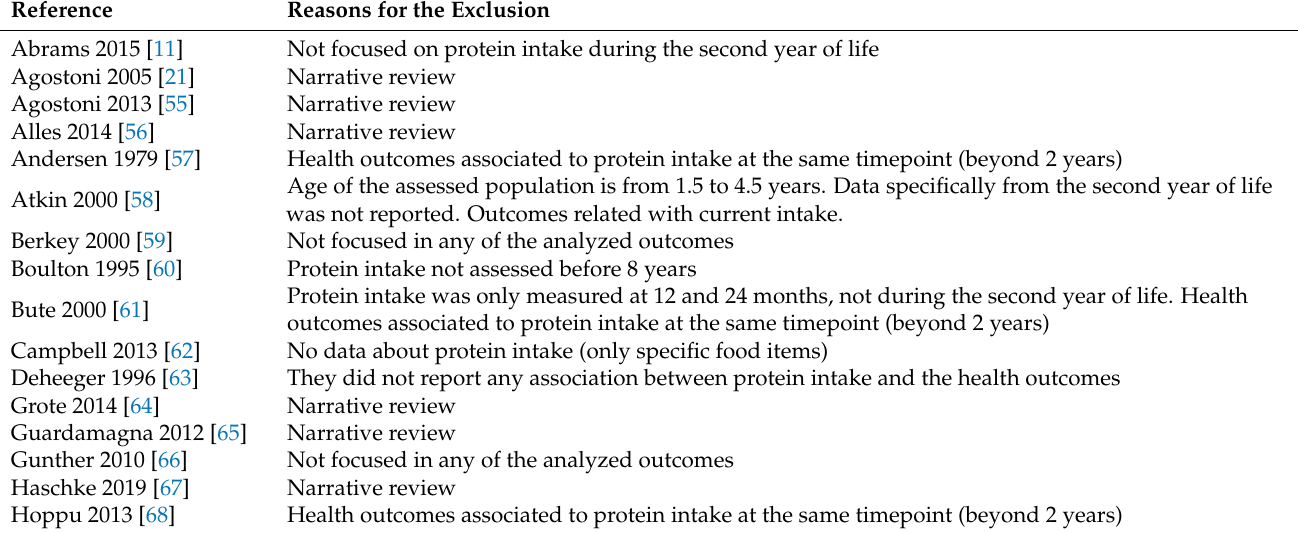
Table A1. Excluded studies and their reasons for